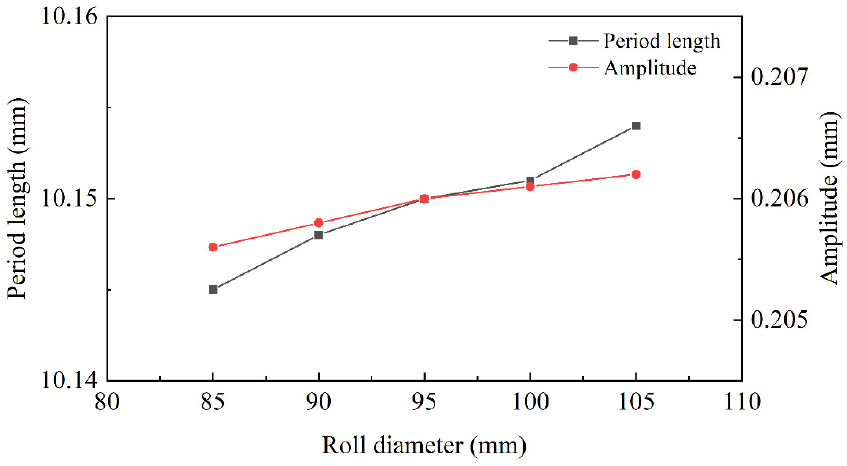
Figure 13. The morphology curve with different roll diameters.